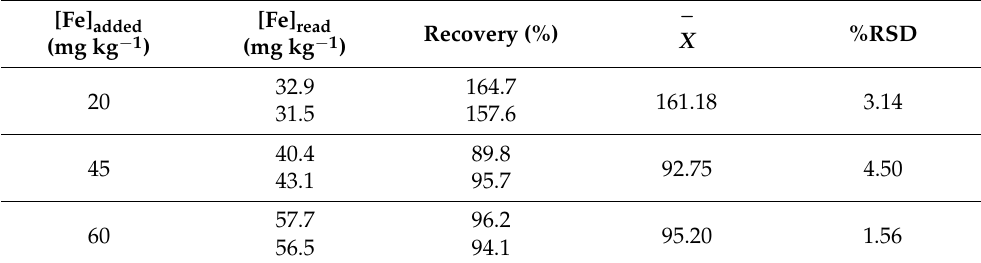
Table 2. Accuracy and precision for iron quantitation in Drosophila melanogaster